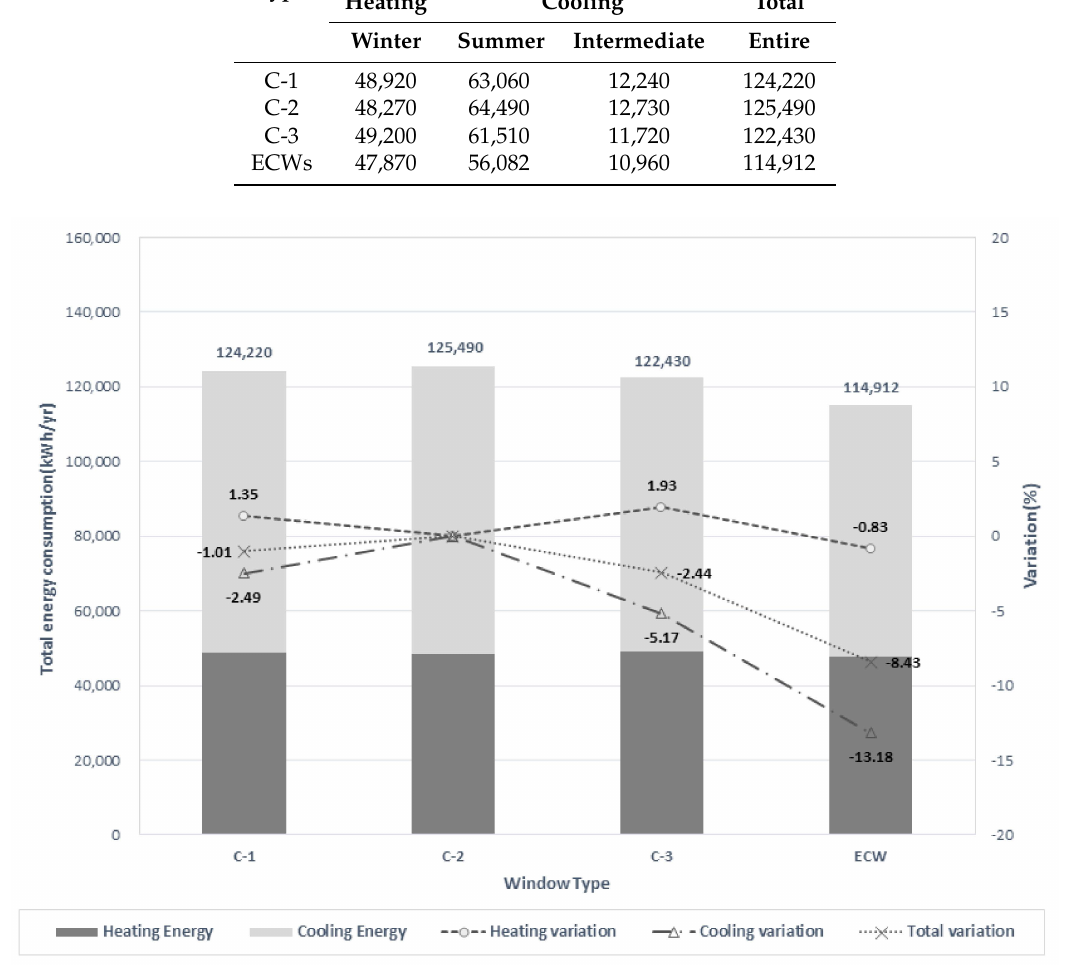
Figure 11. Annual heating and cooling energy consumption. (Variation: A percentage change compared to base